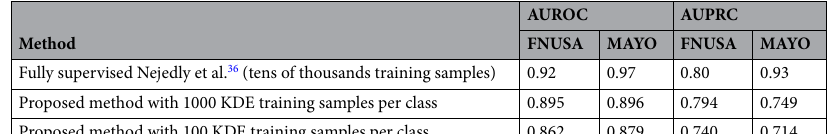
AUROC AUPRC FNUSA MAYO FNUSA MAYO